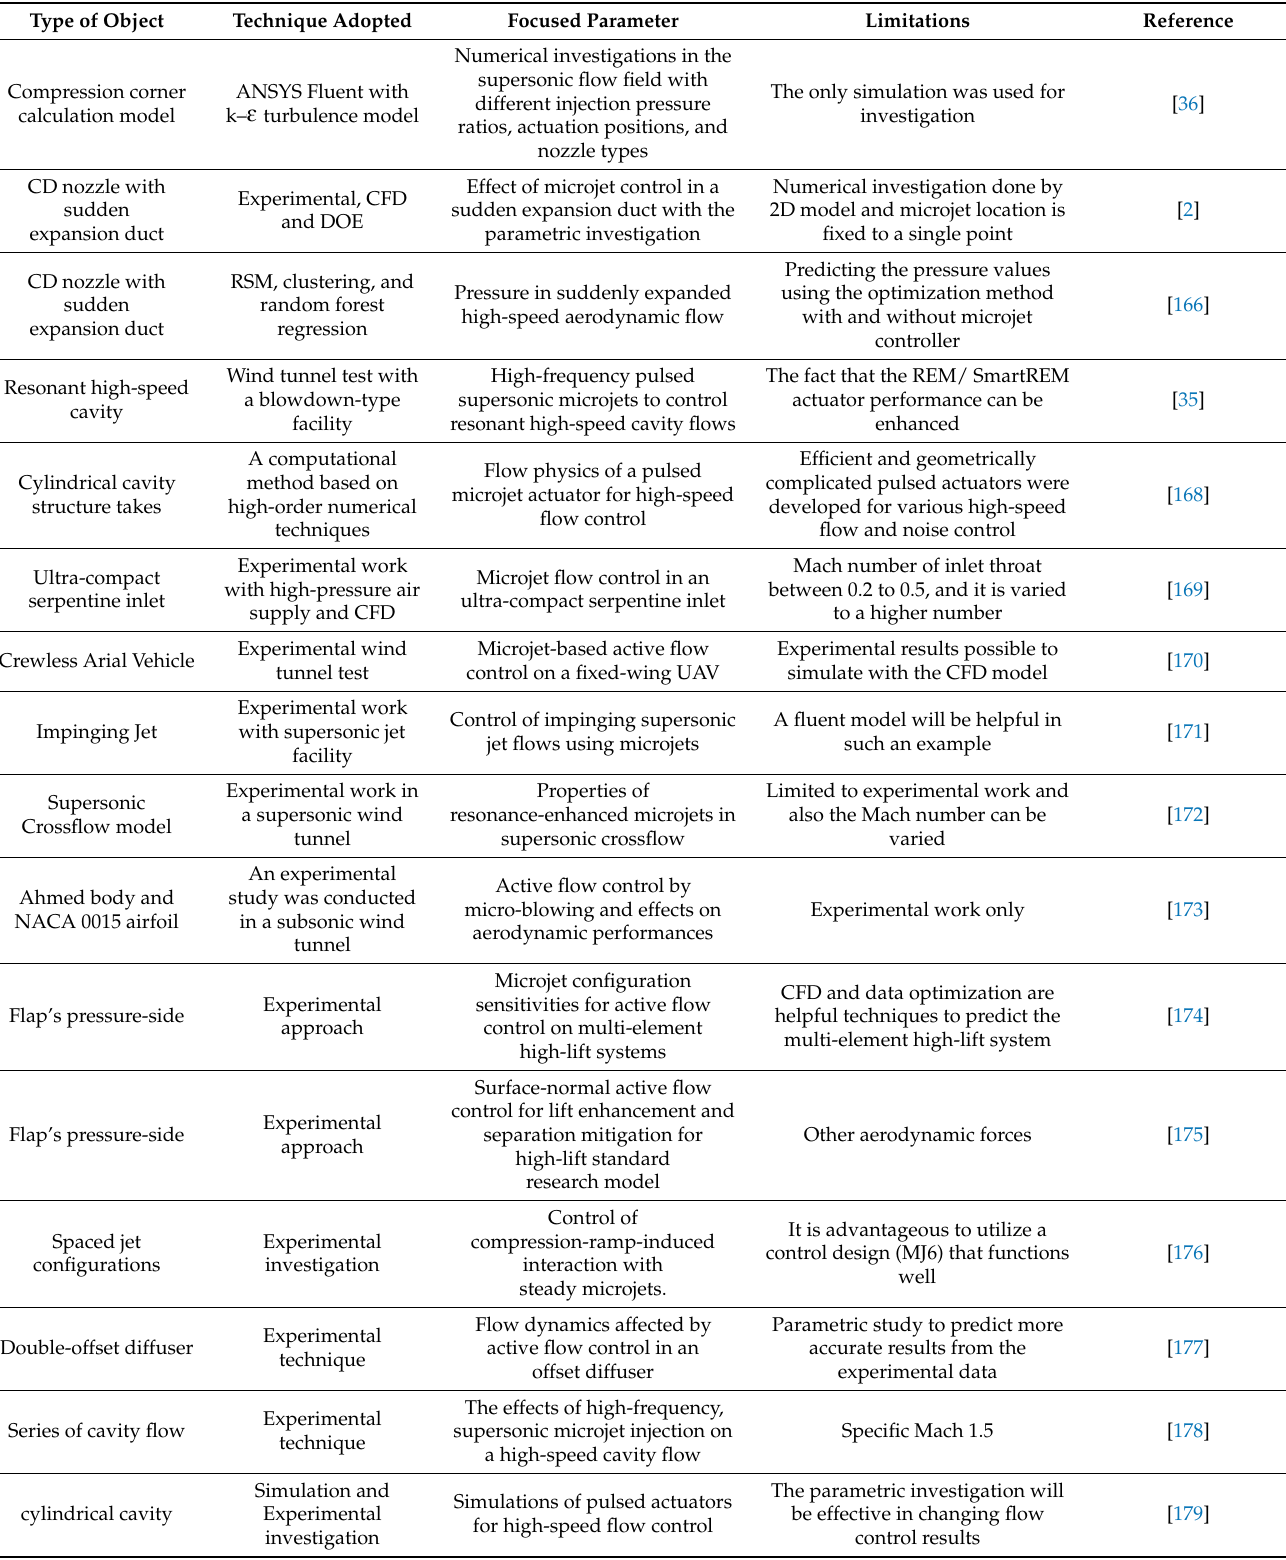
Table 2. Summary and limitations of the flow control method.